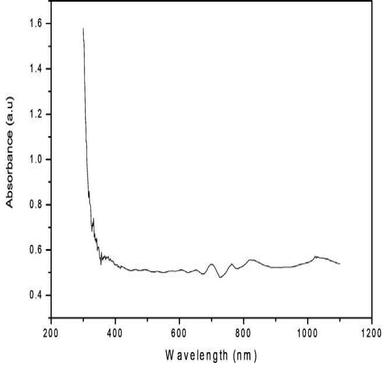
Absorption spectra of ATZC crystal.